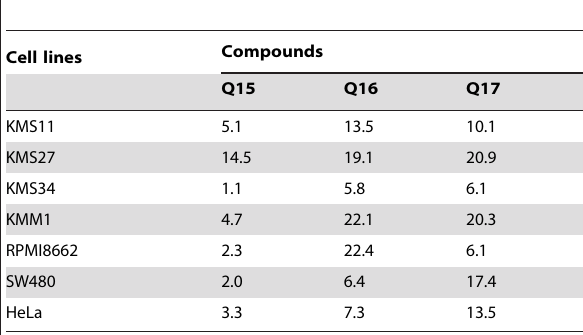
Table 1. IC 50 values ( m M) of anilinoquinazoline derivatives for inhibiting proliferation of different human tumor cell